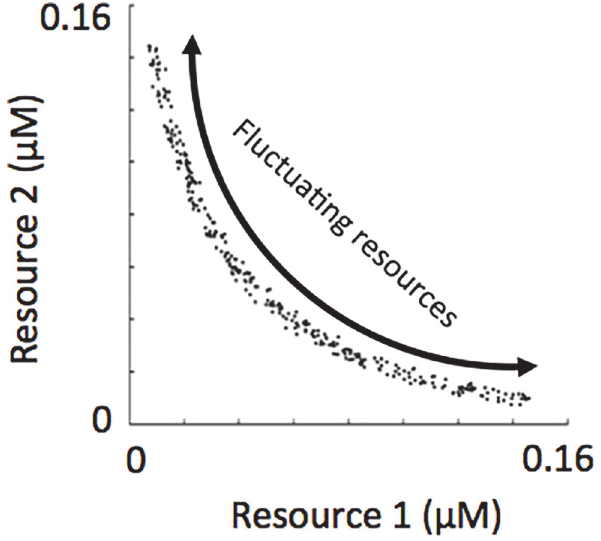
Fig 2. R * s of phytoplankton in the initial species pool and the recurrently fluctuating environmental conditions from which assemblages